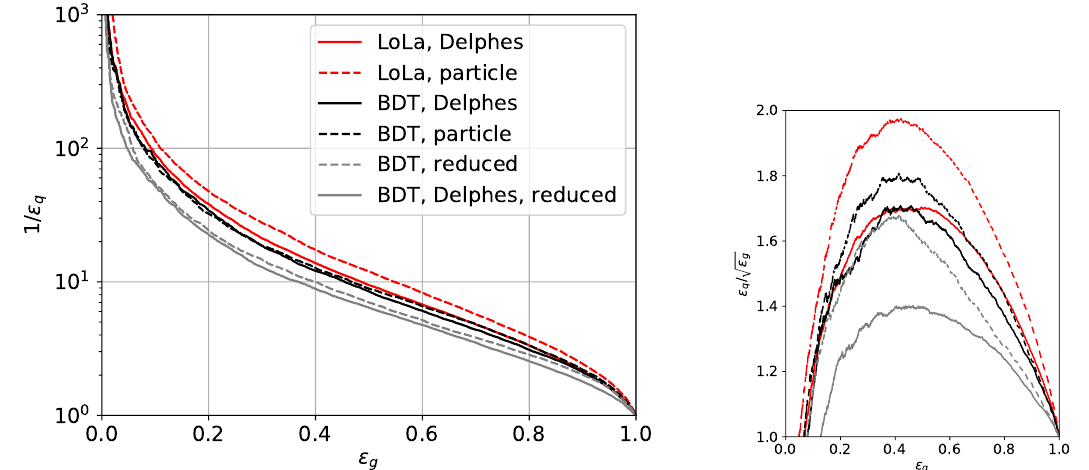
Figure 4: ROC and significance improvement curves for the L O L A tagger trained and tested on pure samples, with and without detector simulation. We compare to a BDT analysis of the full set of of observables, Eq.(10), and to a reduced set of observables,